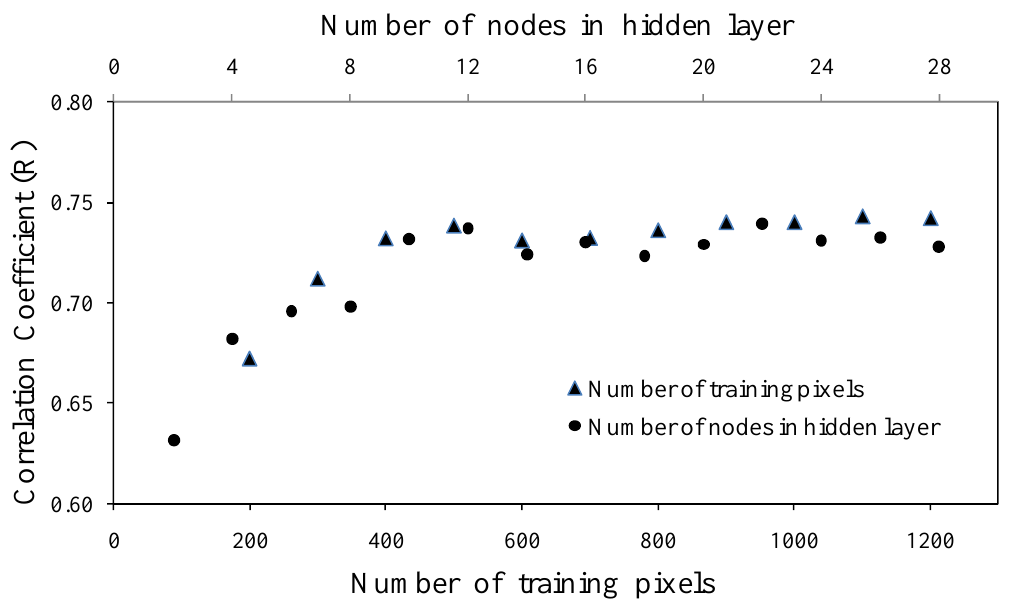
Figure 4. Effect of number hidden nodes in single hidden layer and training pixel on soil moisture retrieval accuracy.